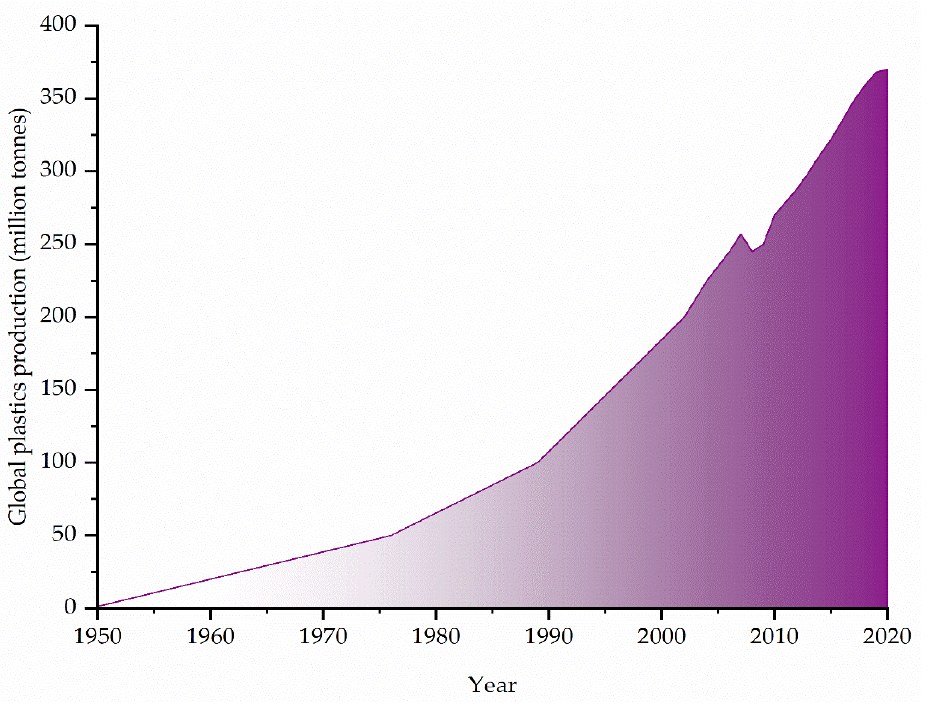
Figure 1. Global plastic production from 1950 to 2020 [5].